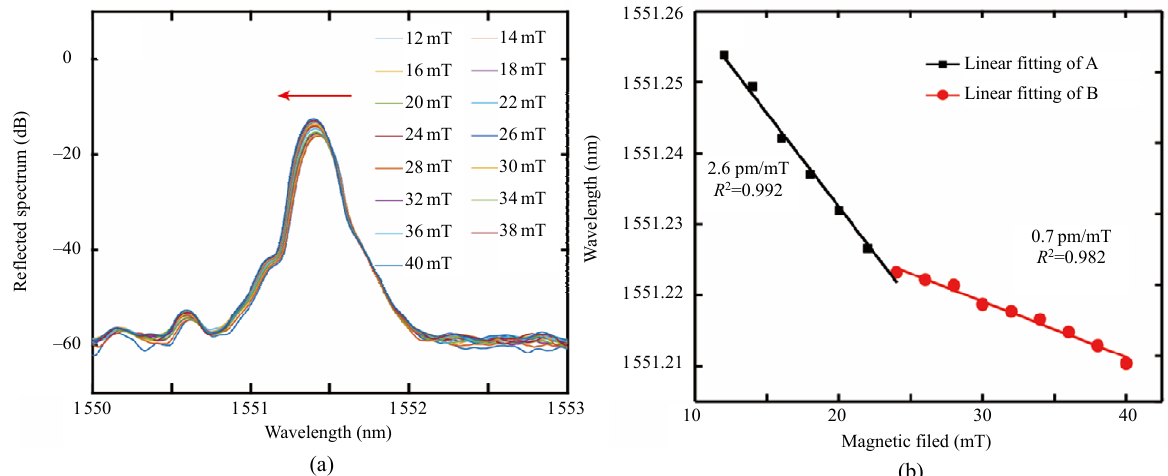
Fig. 3 Spectral response and sensitivity of the designed magnetic field sensor: (a) the measured spectra under different magnetic fields and (b) wavelength shift as a function of the magnetic field.